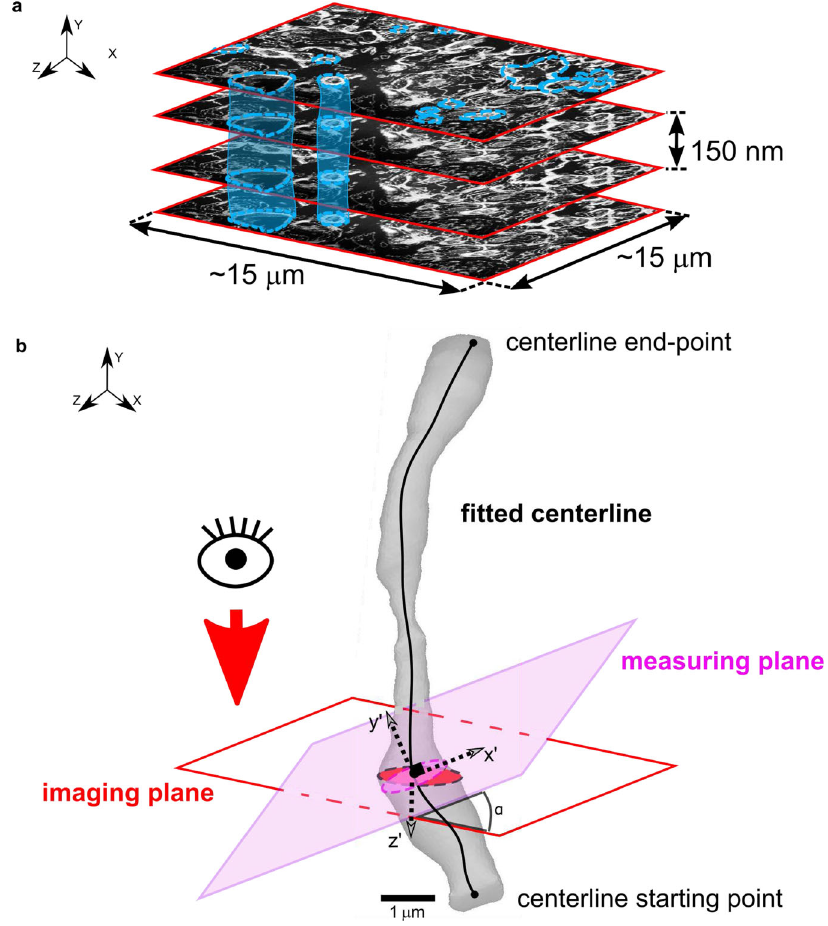
Fig. 4 Segmentation of the axonal features and measurement strategy. a Each stack of images is imported into MIMICS 66 where manual segmentation of the axons is performed. The outer axonal perimeter (myelin ring and axonal body) is traced for each axon in each slice imaged every 150 nm. A 2D mask de fi ning the axons (segmented area) is created in MIMICS following the axonal structure in each slice. b The software extrapolates a 3D entity which is composed of the interpolated masks and fi ts a centerline of the axon. The fi tting of the centerline ensures the creation of a measuring plane (violet) that is constantly perpendicular to the centerline itself. In fact, the imaging plane is generally not perpendicular to the centerline of the axon due to the impossibility of continuously pre-positioning the axon. Therefore, the variable angle α formed between the two planes can often be the cause of inaccuracies and distortions of 2D measurements made on the imaging plane (red). As measurements are taken on the measuring plane, they are unaffected by the distortion. This method ensures a detailed and precise dataset that represents the whole of the axonal structure with a minimal resolution of 150 nm in the